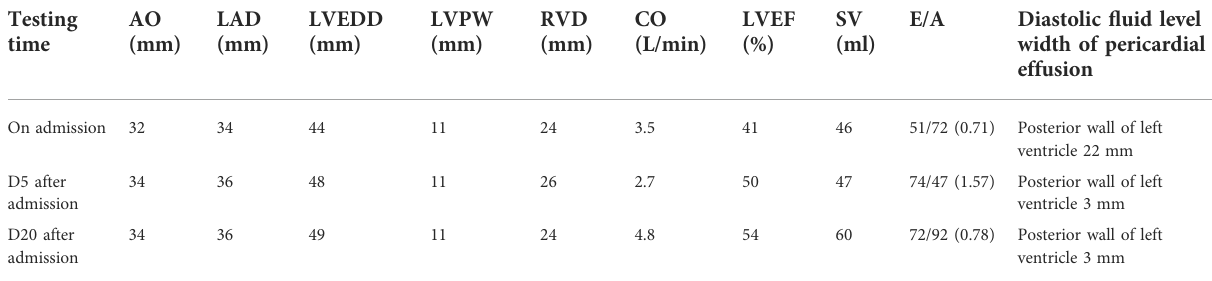
TABLE 2 The dynamic evolution of UCG.